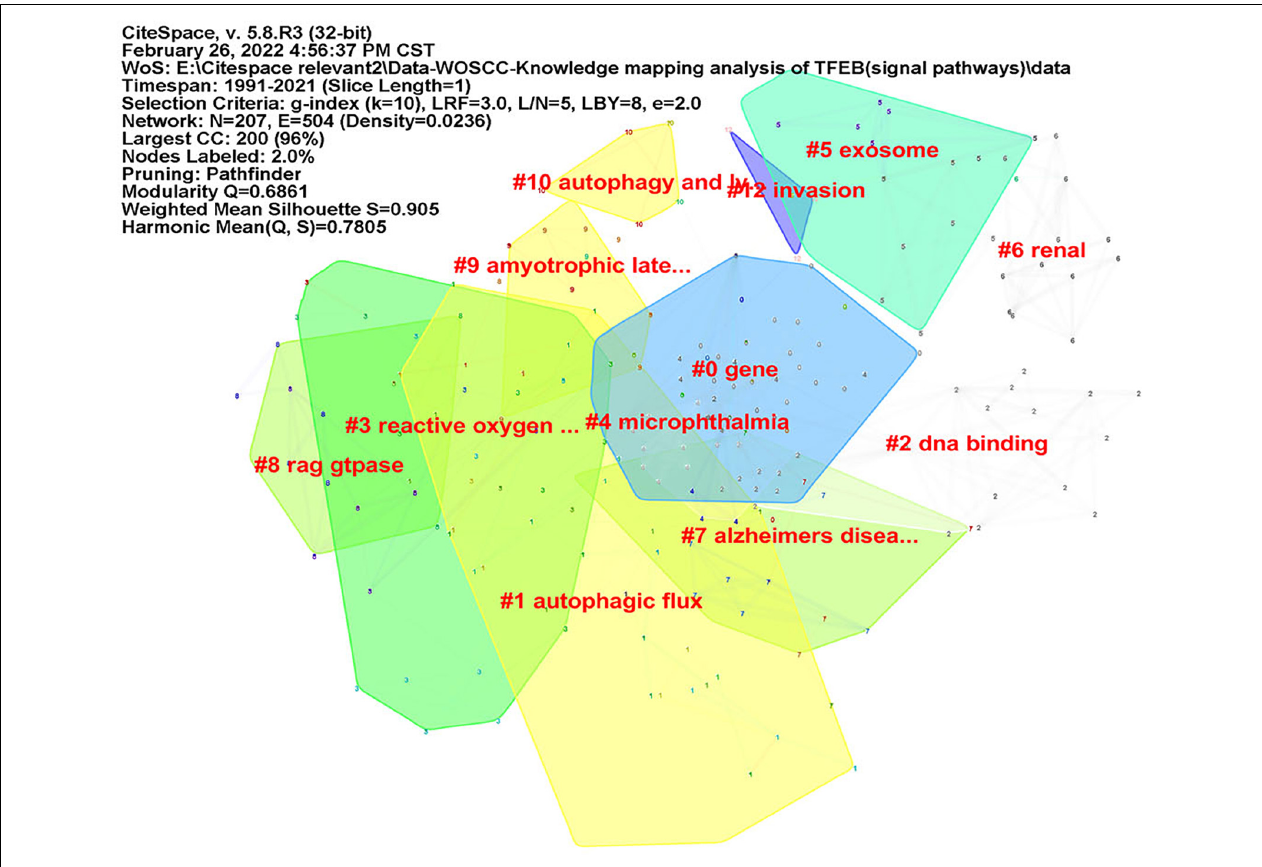
FIGURE 6 | Keyword clusters map of TFEB about “signal